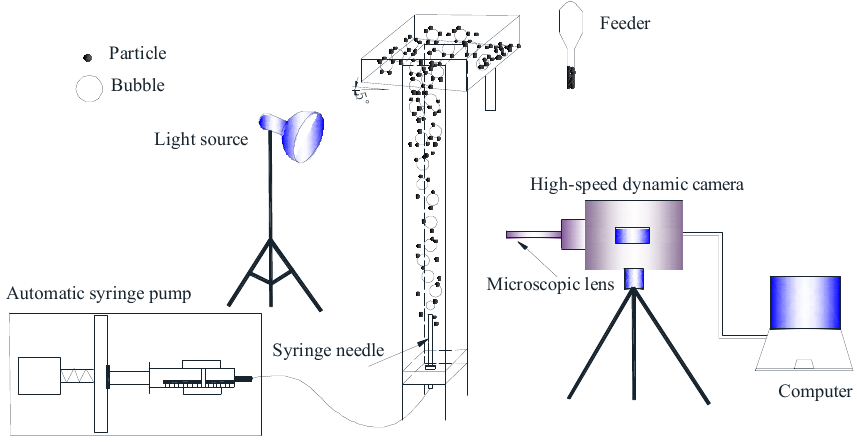
Figure 5. A schematic of the single rising bubble device.